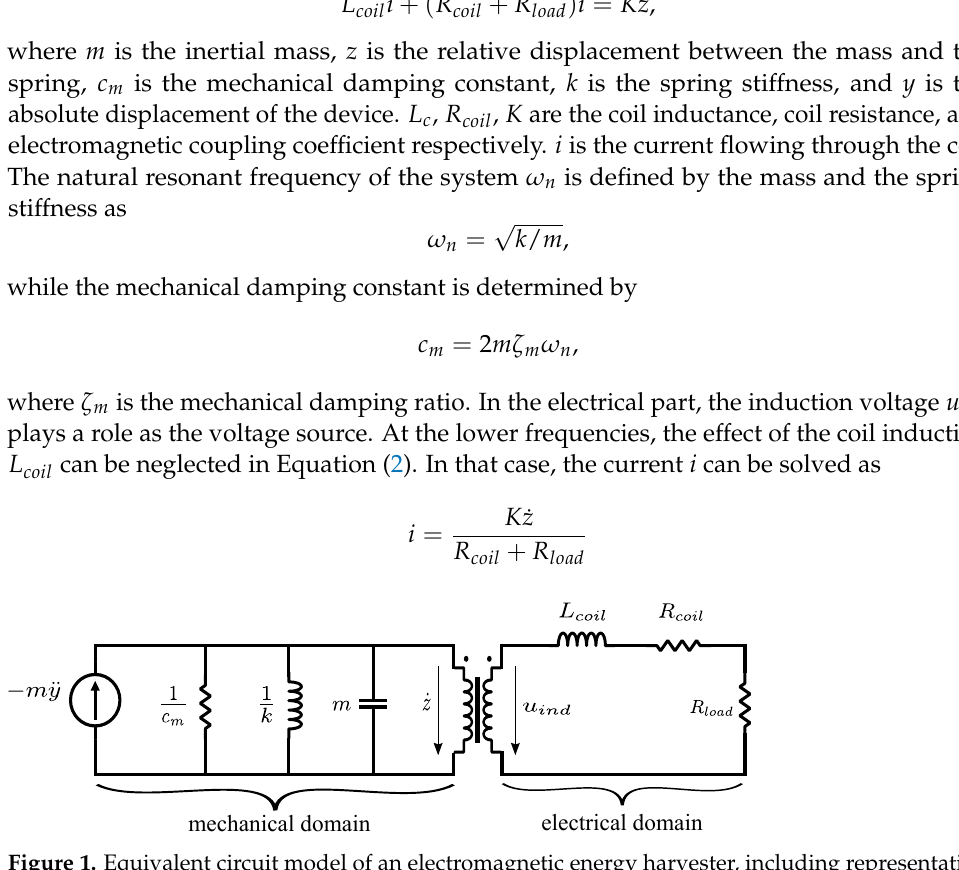
Figure 1. Equivalent circuit model of an electromagnetic energy harvester, including representation of the mechanical and electrical